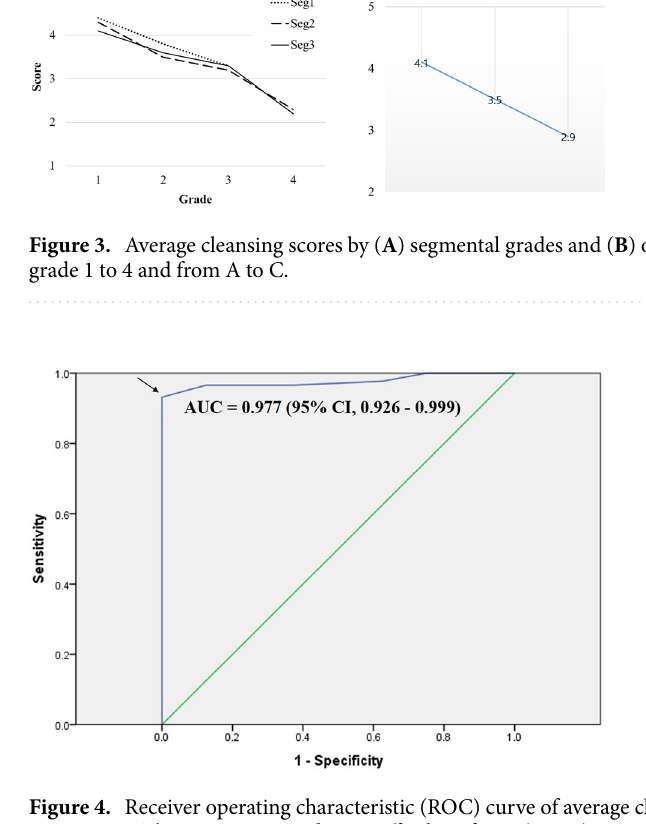
Figure 4. Receiver operating characteristic (ROC) curve of average cleansing score for clinically adequate preparation. The curve estimated a cut-off value of 3.25 (arrow). AUC, area under the curve.